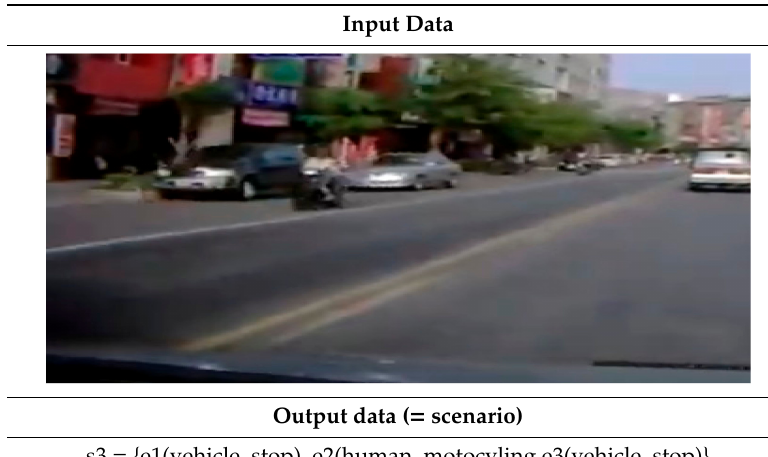
Table 8. Scenario Generation Result #3.